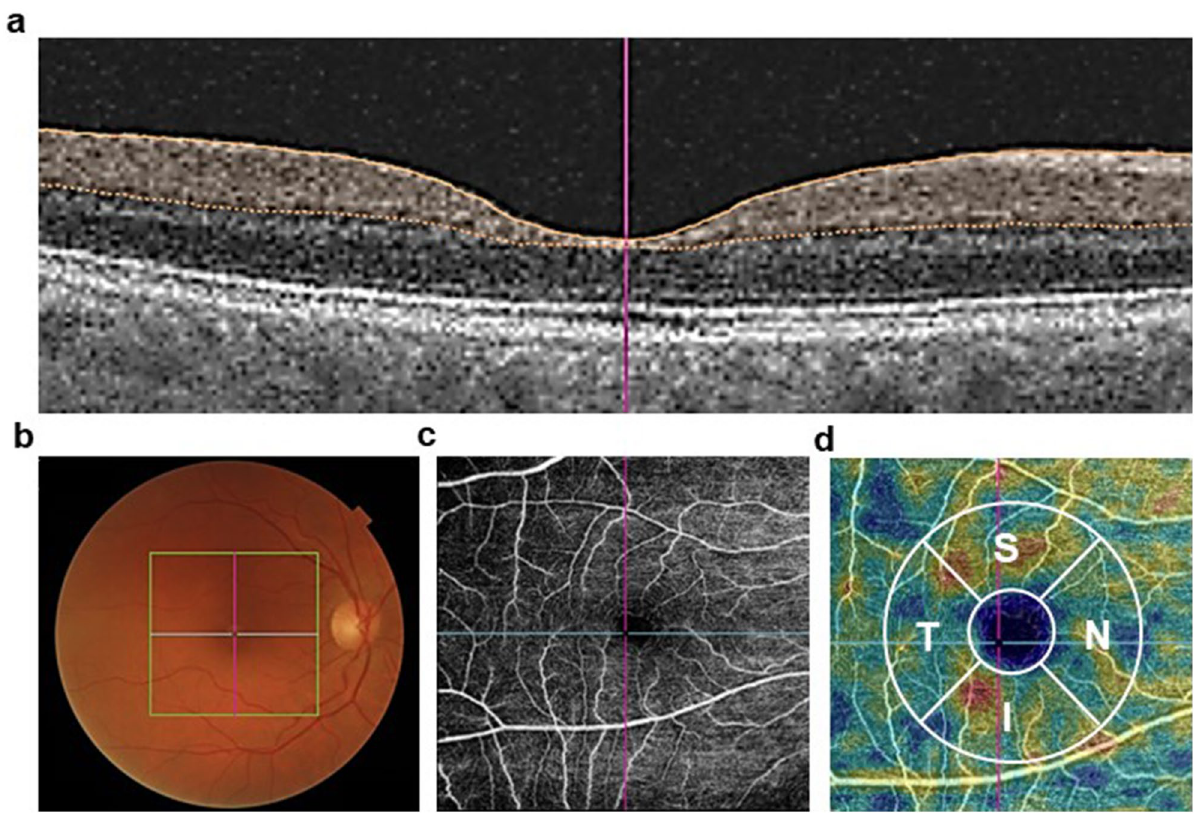
Figure 4. OCT-A imaging protocol. Limits of the superficial vascular plexus at the macular region ( a ). Grid on the macular region of the right eye ( b ). Vessels from the superficial vascular plexus at the macular region ( c ). The four macular quadrants analyzed (N, S, T and I) are depicted ( d ). C = center, N = nasal, S = superior, T = temporal and I =